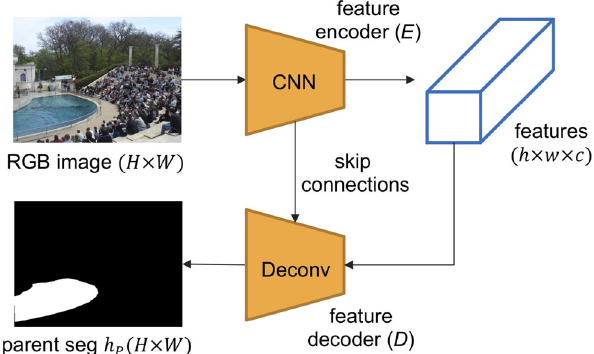
Fig. 3 Overview of ParentNet. ParentNet consists of a feature encoder E and a decoder D . The encoder uses the ResNet-34 architecture and is pre-trained on ImageNet and then fine-tuned on WaterDataset